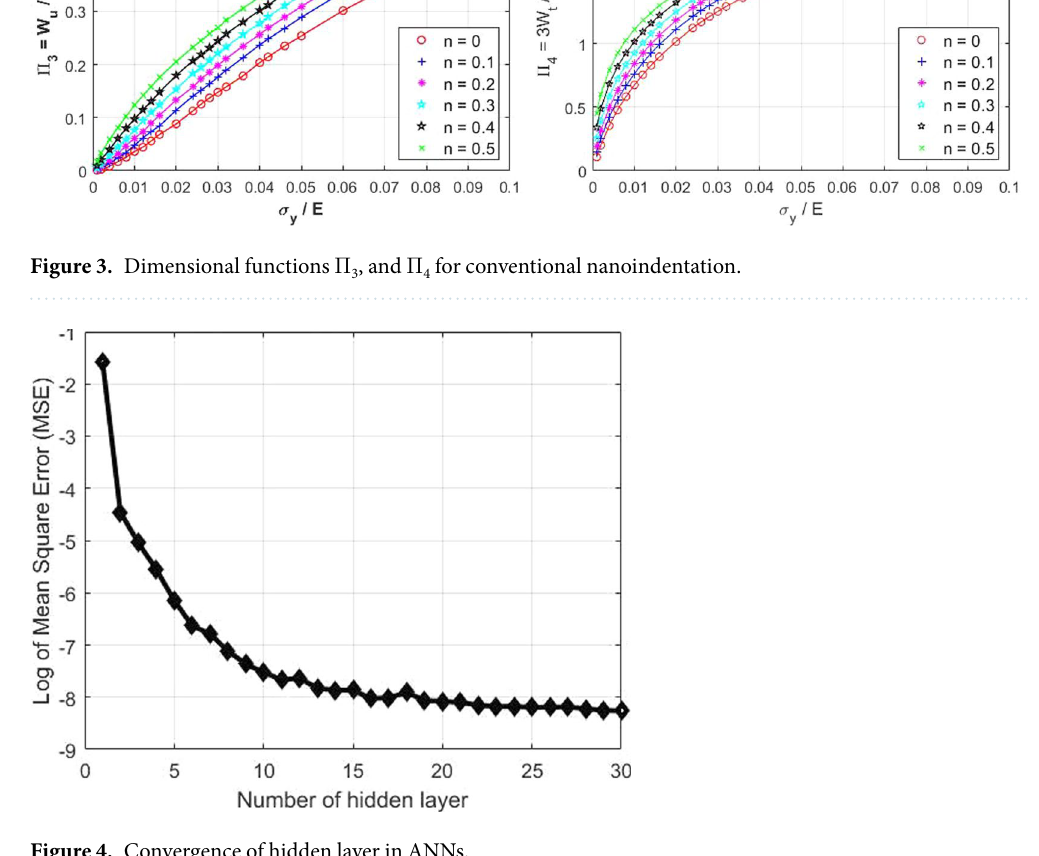
Figure 4. Convergence of hidden layer in